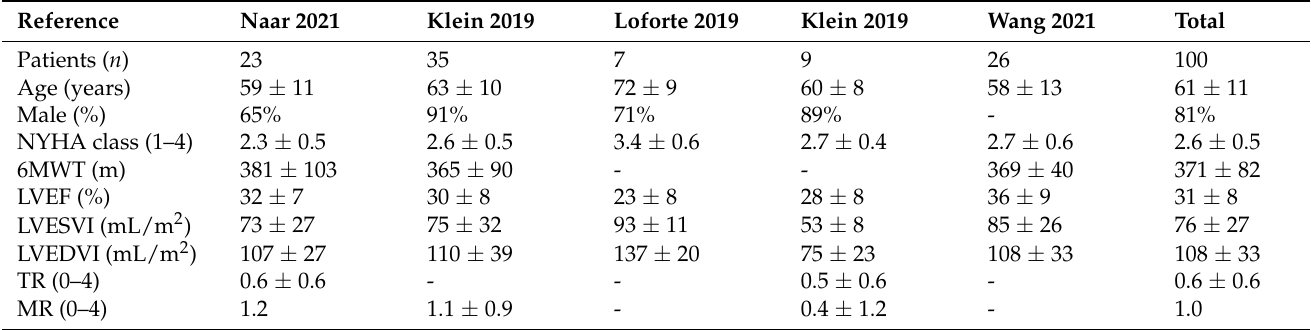
Table 3. Baseline characteristics of previous studies.